Question: What visual encoding does this figure use to show its data?
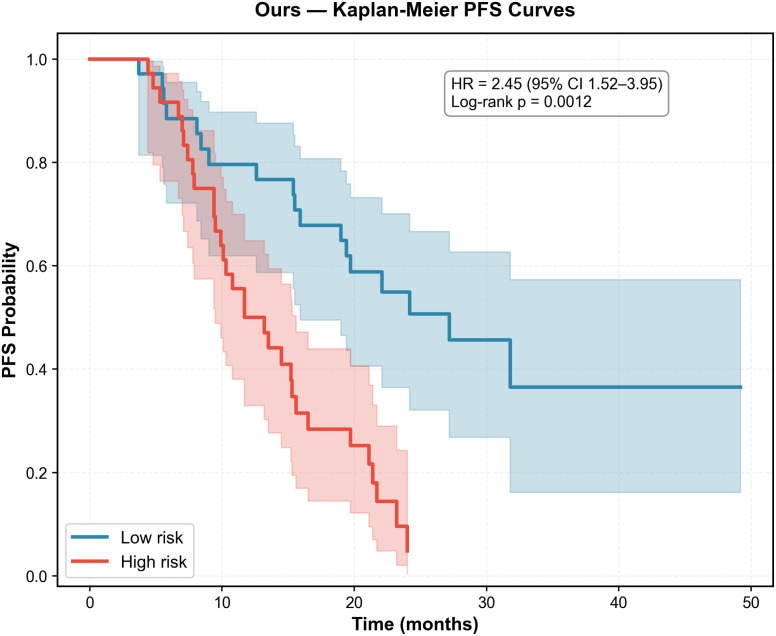
Answer: survival